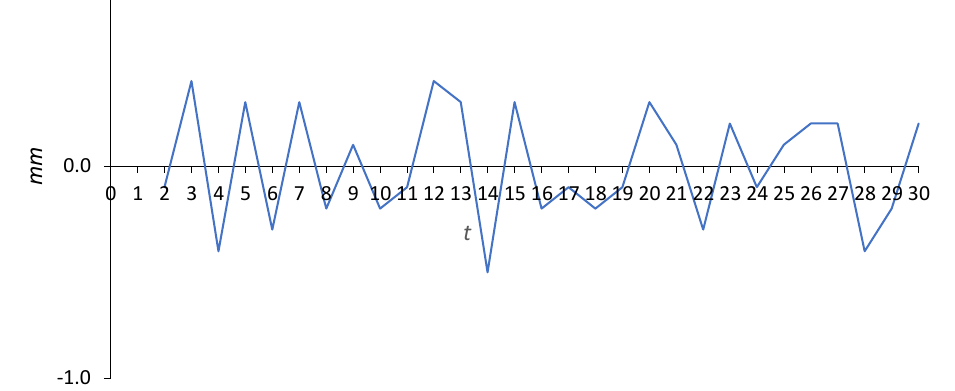
-1.0 Figure 7. Stationary series. Figure 7. Stationary series. Obviously, the stationary time series belongs to the MD state of the series, so we must transform it to the NN state of the series. The way of transformation is presented in Table 10 and Figure